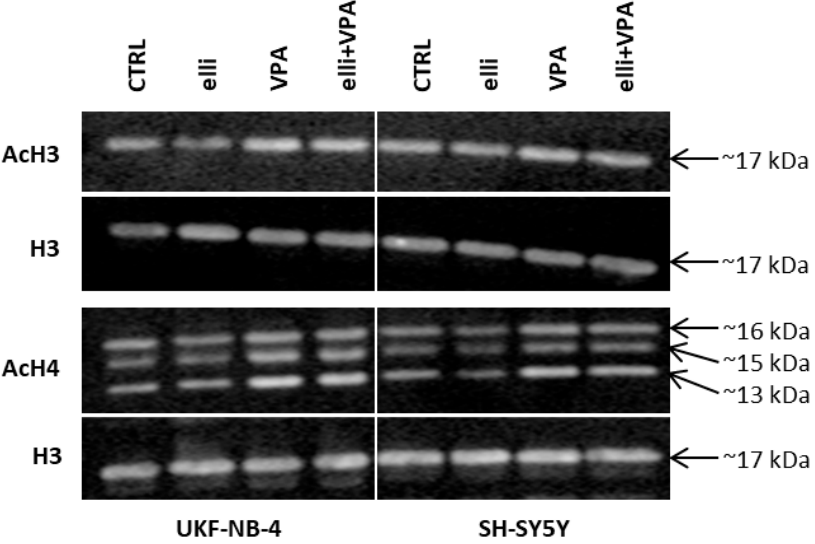
Figure 8. Western blot analysis of acetylated histones H3 (AcH3) and H4 (AcH4) in extracts from UKF-NB-4 and SH-SY5Y cells treated with 5 µ M ellipticine (elli), 1 mM VPA and their combination. Histone H3 was used as loading control. Representative data from one of three independent experiments are shown.